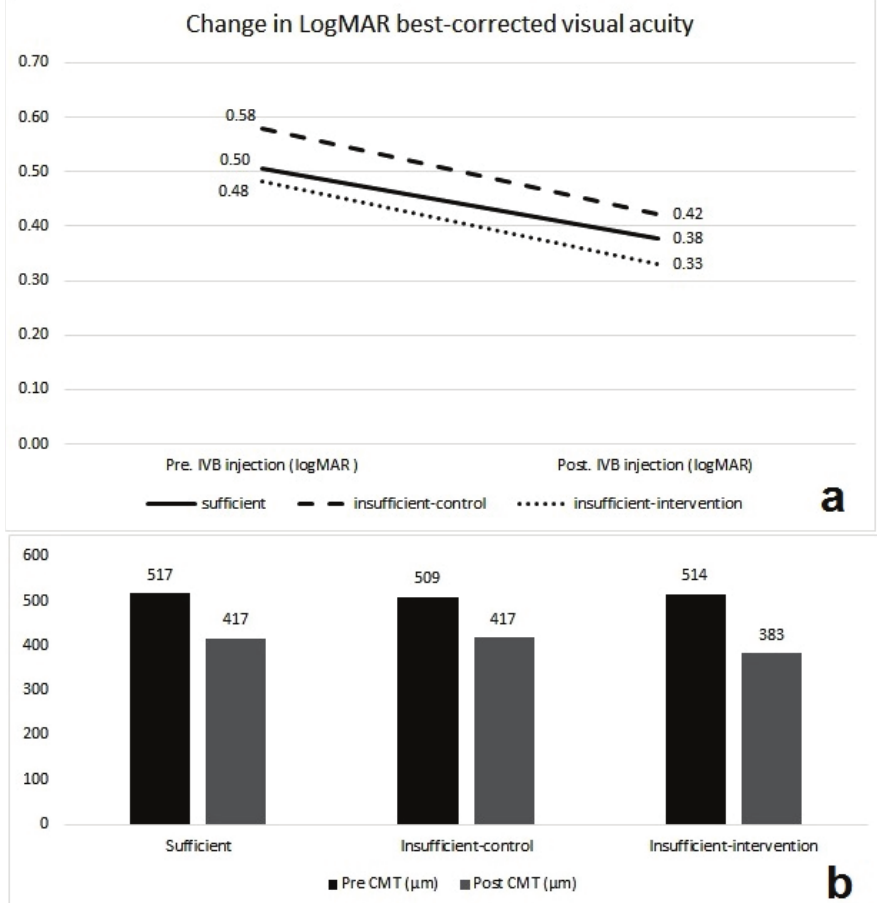
Figure 3. Changes in visual acuity (a) and central retinal thickness (b) following IVB therapy. CMT, central macular thickness; LogMAR, logarithm of minimal angel resolution; IVB, intravitreal